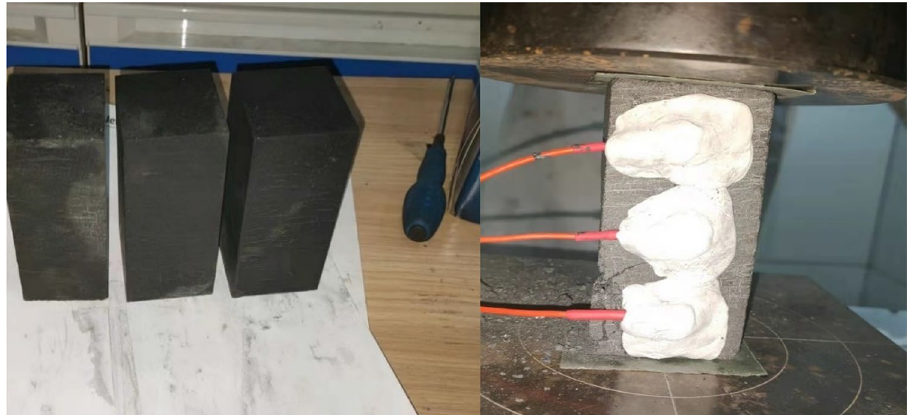
Figure 1. Coal samples from Shanxi